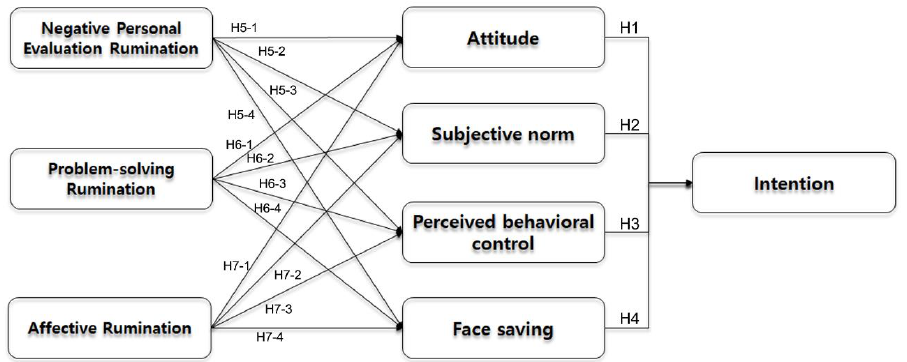
Figure 1. Research